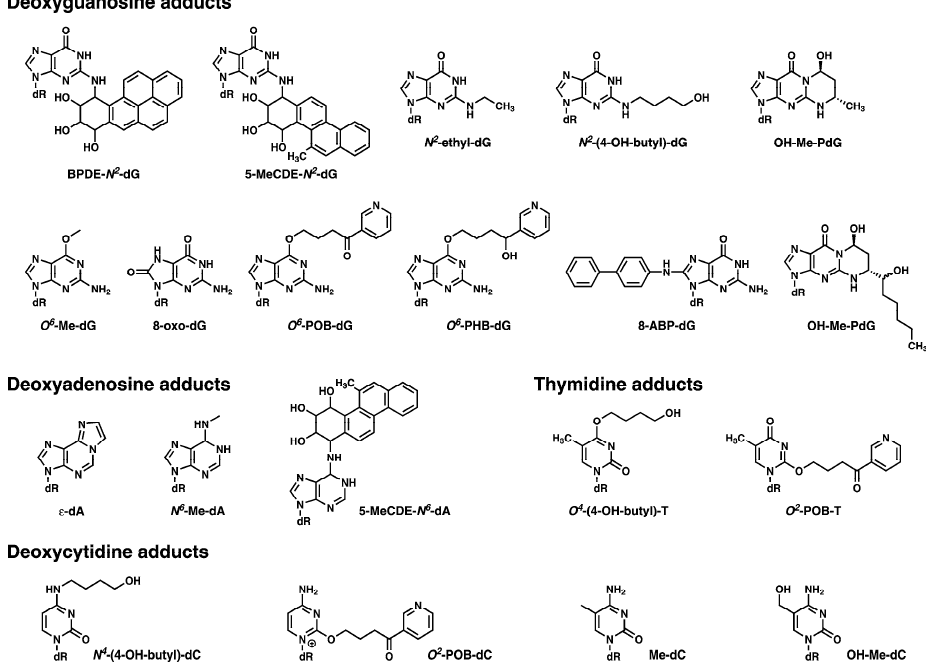
Figure 3. Examples of the type of DNA modifications that can be analyzed with mass spectrometry-based DNA adductomic approaches. The deoxyribose moiety of the structure is abbreviated as dR.